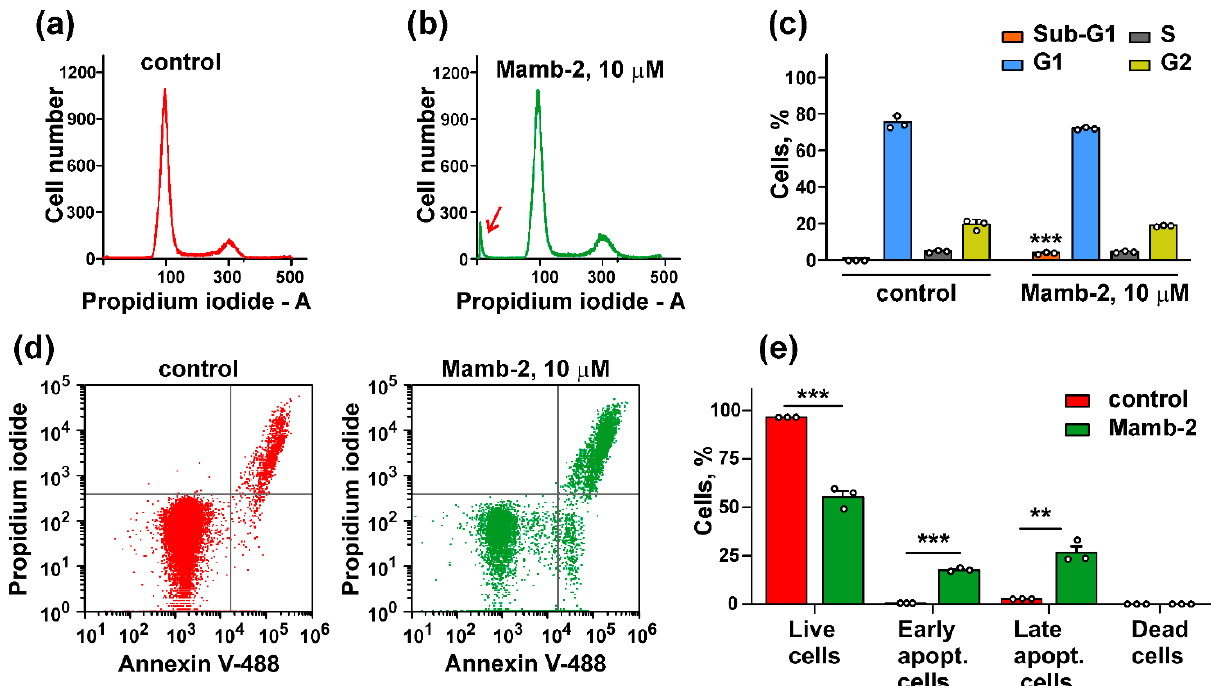
Figure 7. Apoptosis induction by mambalgin-2 in mel P cells: ( a,b ) Representative nuclei population distribution of mel P cells cultivated at pH 6.5 in absence (control, a ) or presence of 10 µ M mambalgin-2 ( b ). Peak corresponding to the Sub-G1 cell population is shown by red arrow; ( c ) % of cells in each cell cycle phase. Data are presented as % of cells in each cell cycle phase ± SEM ( n = 3). *** ( p < 0.001) indicates significant difference between the sub-G1 nuclei groups by two-tailed t -test; ( d ) representative pictures of phosphatidylserine externalization analysis upon the 10 µ M mambalgin-2 treatment of mel P cells by flow cytometry with Annexin V-488 and Propidium iodide (control is without mambalgin-2); ( e ) percentage of mel P cells with externalized phosphatidylserine and bound propidium iodide in absence (control) or presence of 10 µ M mambalgin-2. The data are presented as % of live, early apoptotic, late apoptotic and dead cells ± SEM ( n = 3). ** ( p < 0.01) and *** ( p < 0.001) indicate the significant difference between data groups by a two-tailed t